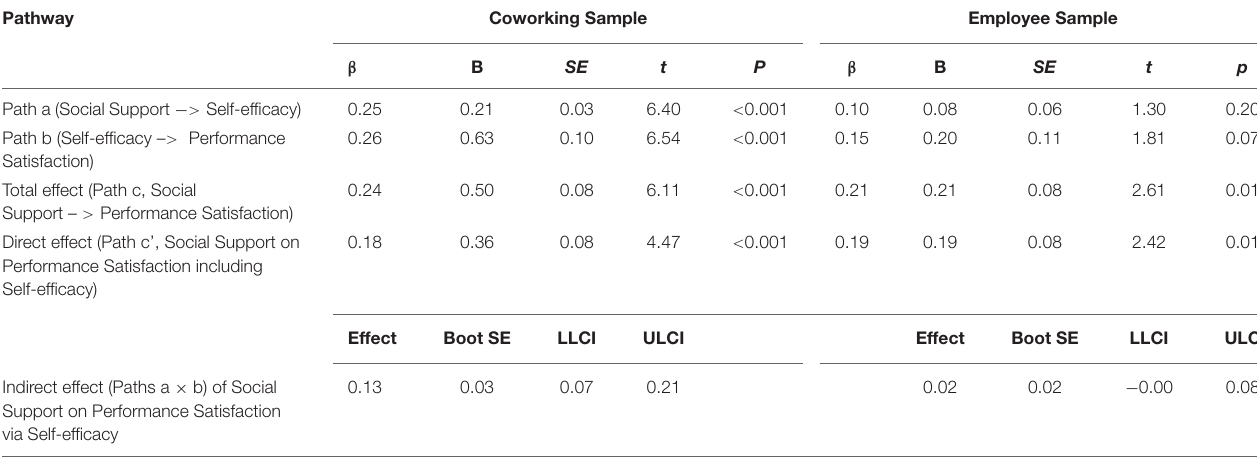
TABLE 3 | Results for testing mediation of self-efficacy.